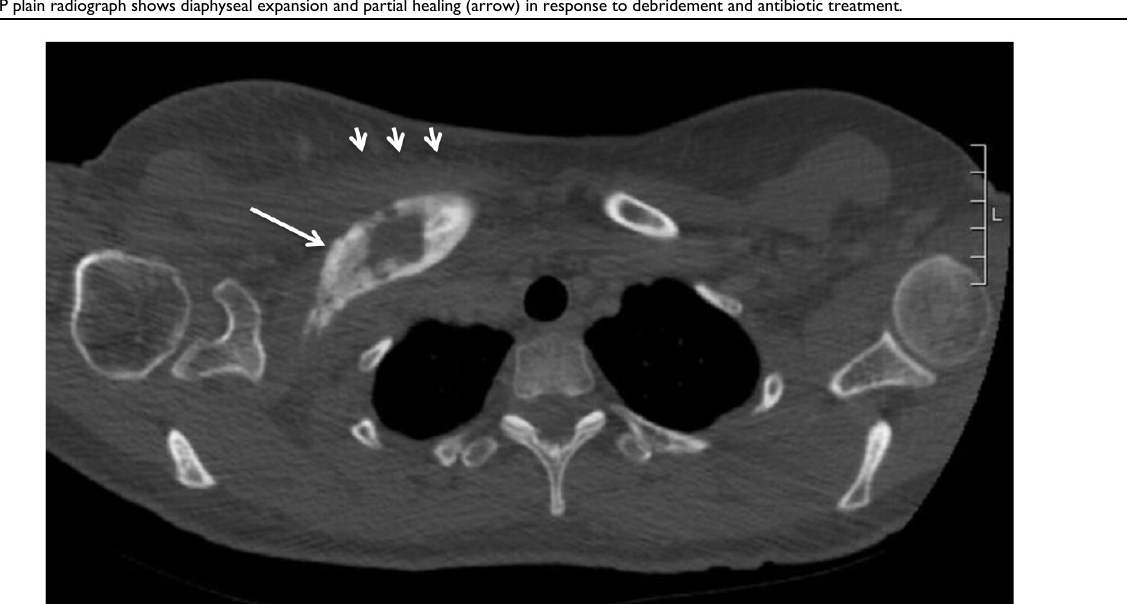
Figure 4. AP plain radiograph shows diaphyseal expansion and partial healing (arrow) in response to debridement and antibiotic treatment.